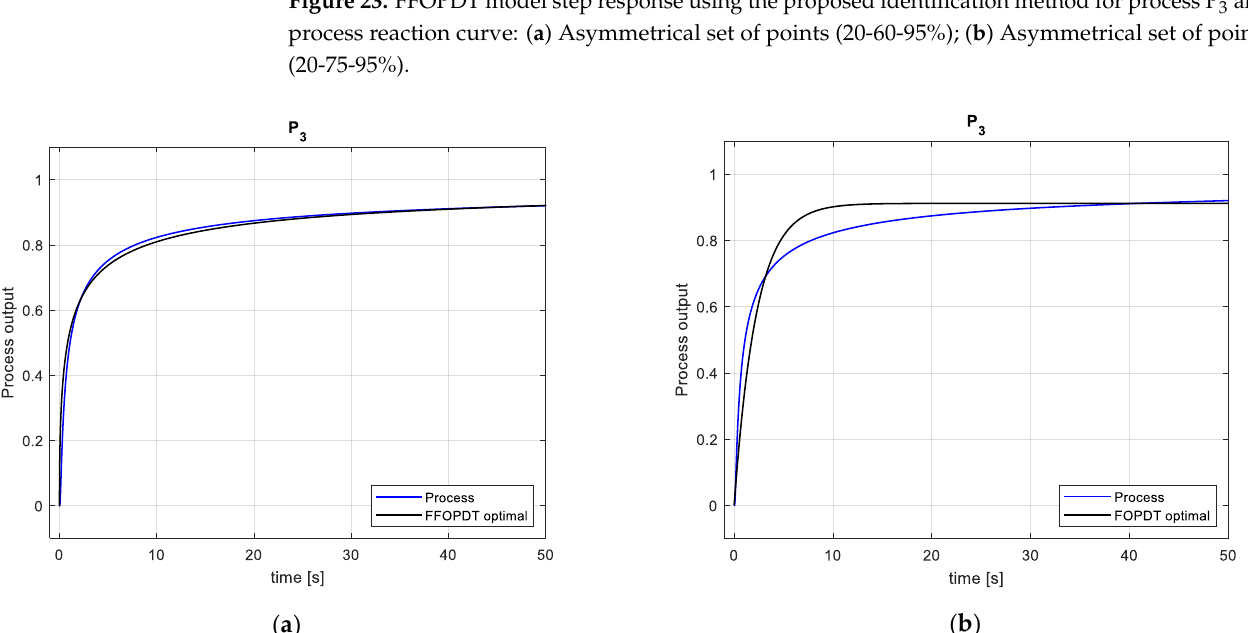
Figure 23. FFOPDT model step response using the proposed identification method for process P 3 and process reaction curve: ( a ) Asymmetrical set of points (20-60-95%); ( b ) Asymmetrical set of points (20-75-95%).